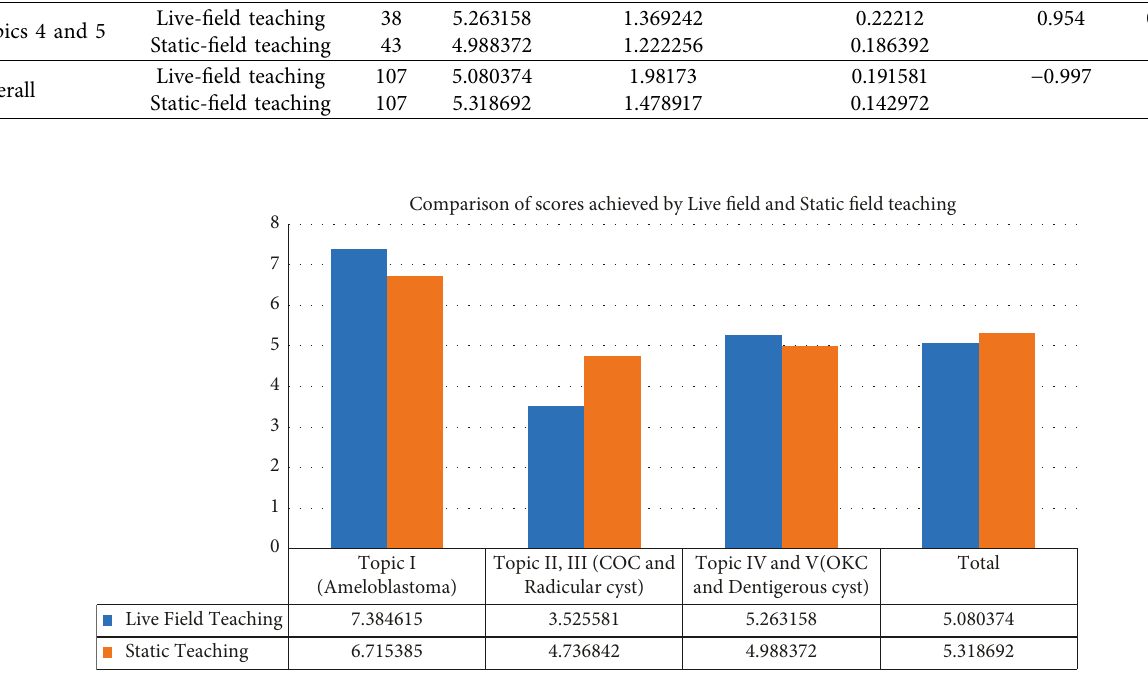
Figure 2: Comparison of scores achieved by students trained with live-field and static-field